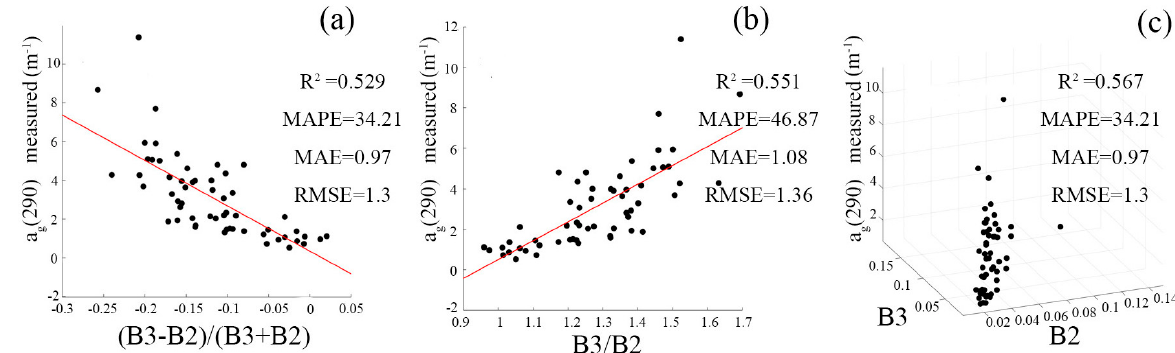
Figure 5. Validation results obtained using the empirical algorithm of Equation (8) ( a ), Equation (9) ( b ), and Equation (10) ( c ).